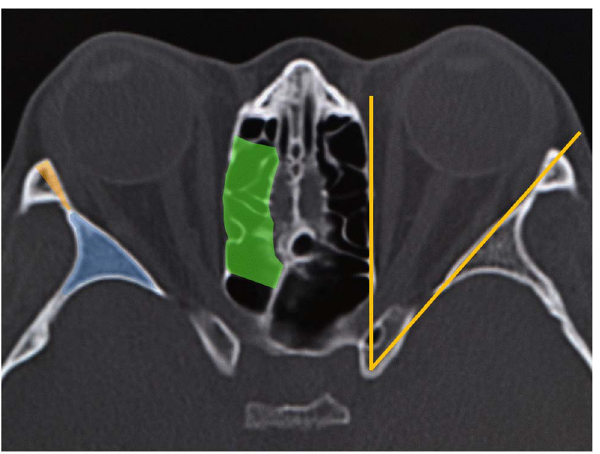
Figure 1. Axial computed tomographic image of the orbit. In the lateral orbital wall decompression, the greater wing of the sphenoid (the blue area), and ‘‘the medial eaves’’ of the lateral orbital rim (the orange area) were removed. In the medial orbital wall decompression, the medial orbital wall with its periosteum and the septa of the ethmoid air cells (the green area) were removed. The lateral walls are oriented to an angle of 45 degrees lateral to the sagittal plane, whereas the medial walls of each orbit are oriented in the sagittal plane (the yellow solid lines).